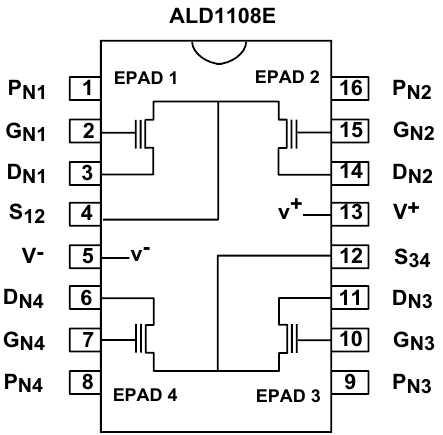
Figure 3. Pinout of the integrated circuit ALD1108E